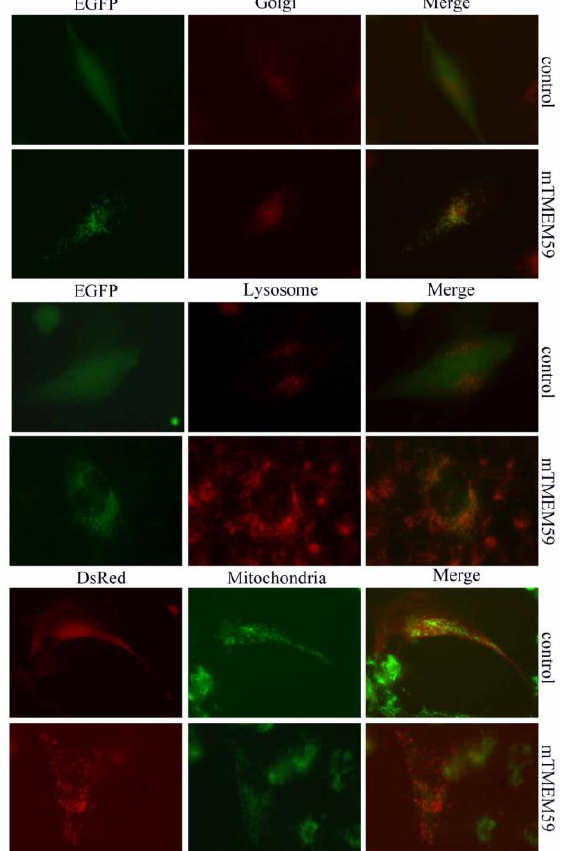
Figure 4. Subcellular localization of TMEM59. The TMEM59 – EGFP fusion protein was transiently expressed in U251 cells. Golgi Tracker Red and LysoTracker Red staining are shown in parallel. TMEM59-DsRed was transiently expressed in U251 cells. MitoTracker Green is shown in parallel. All merged pictures are shown in the rightmost panels.